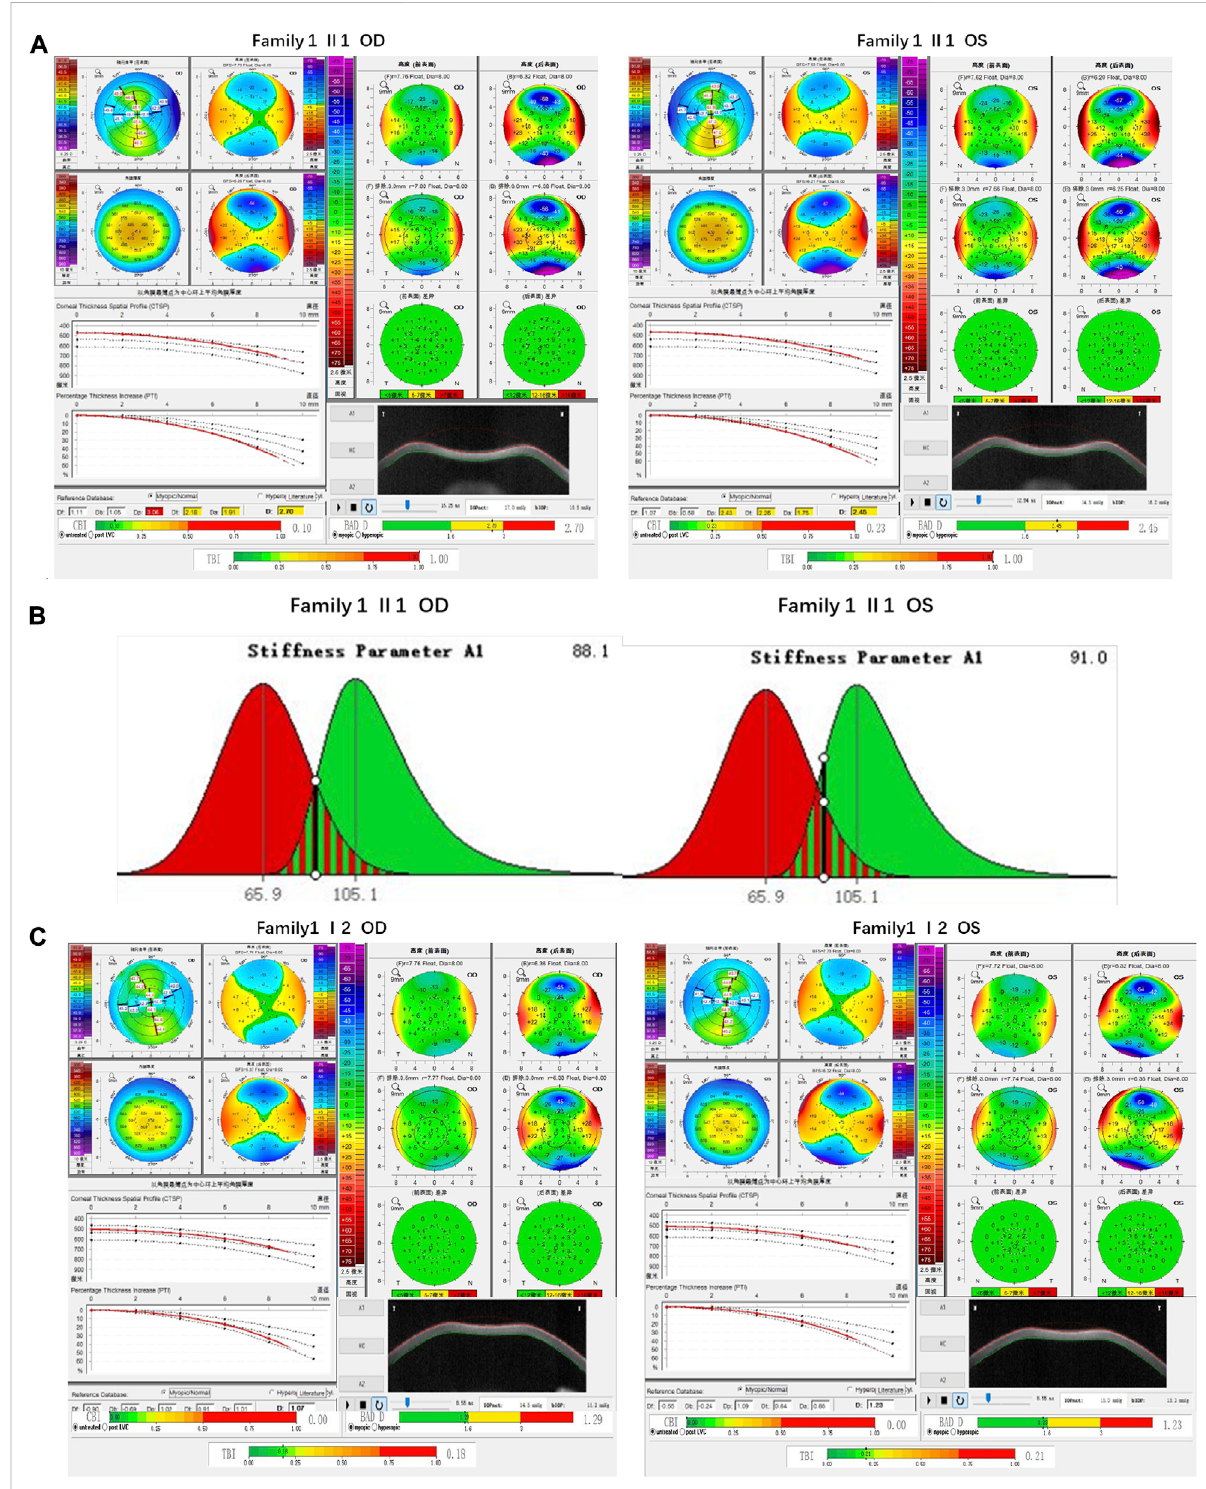
FIGURE 1 Corneal topographic mapand corneal biomechanicalexaminationin family 1. (A) TP, Dp(OS), Dt, Da, D,and BAD-D ofprobandsare suspicious values (yellow); Dp (OD) and TBI are pathological values (red); PTI abnormalities: Showing abnormal distribution of corneal thickness; corneal thickness became thinner (471 μ m in the right eye and 469 μ m in the left eye); curvature: 45.3D below 43.0D above in the right eye, 47.1D below 43.0D above in the left eye (difference 4.1D below and above) (B) SP-A1 < 105.2 (88.1 in the right eye and 91 in the left eye): Smaller value, represent the greater the risk of corneal dilatation (C) All parameters of corneal topography and corneal biomechanics of the proband ’ s mother are